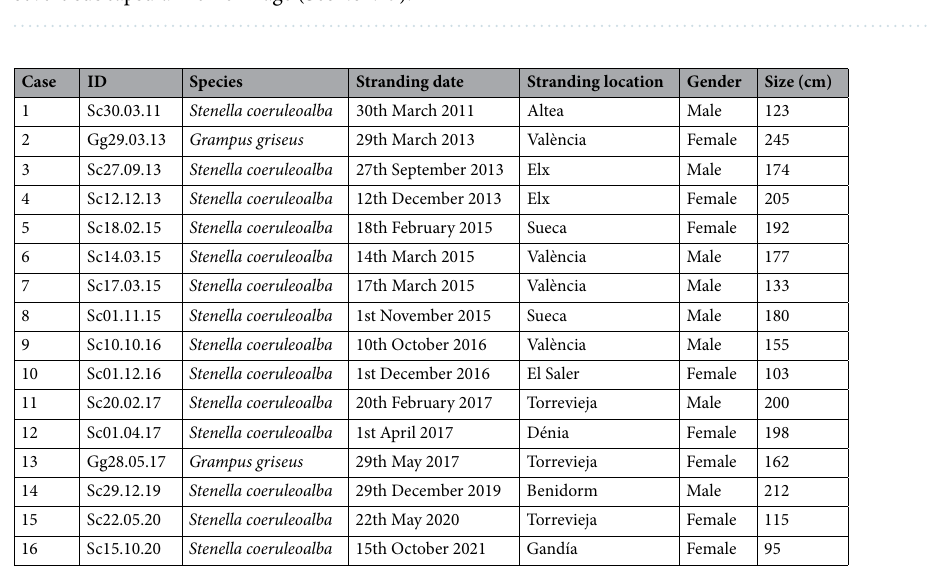
Figure 2. Representative internal macroscopic findings in striped dolphins. ( A ) Skull fracture (Sc30.03.11). ( B ) Multiple intercostal muscle fracture, hematoma and hemorrhage (Sc01.11.15). ( C ) Lung fracture and hematoma (Sc30.03.11). ( D ) Large intrabronchial clot (Sc18.02.15). ( E ) Hemoabdomen (Sc12.01.16). ( F ) Enlarged kidney, severe subcapsular hemorrhage (Sc01.04.17).